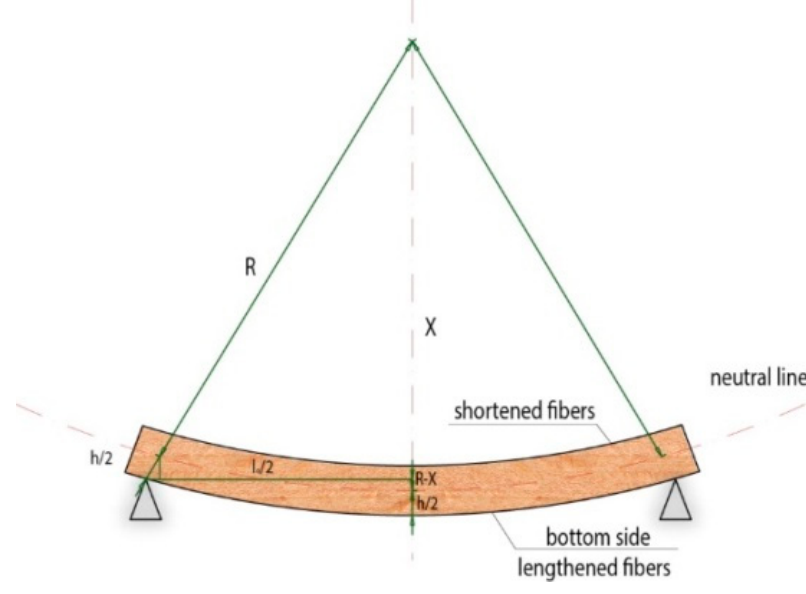
Figure 1. Bending Figure 1. Bending geometry.